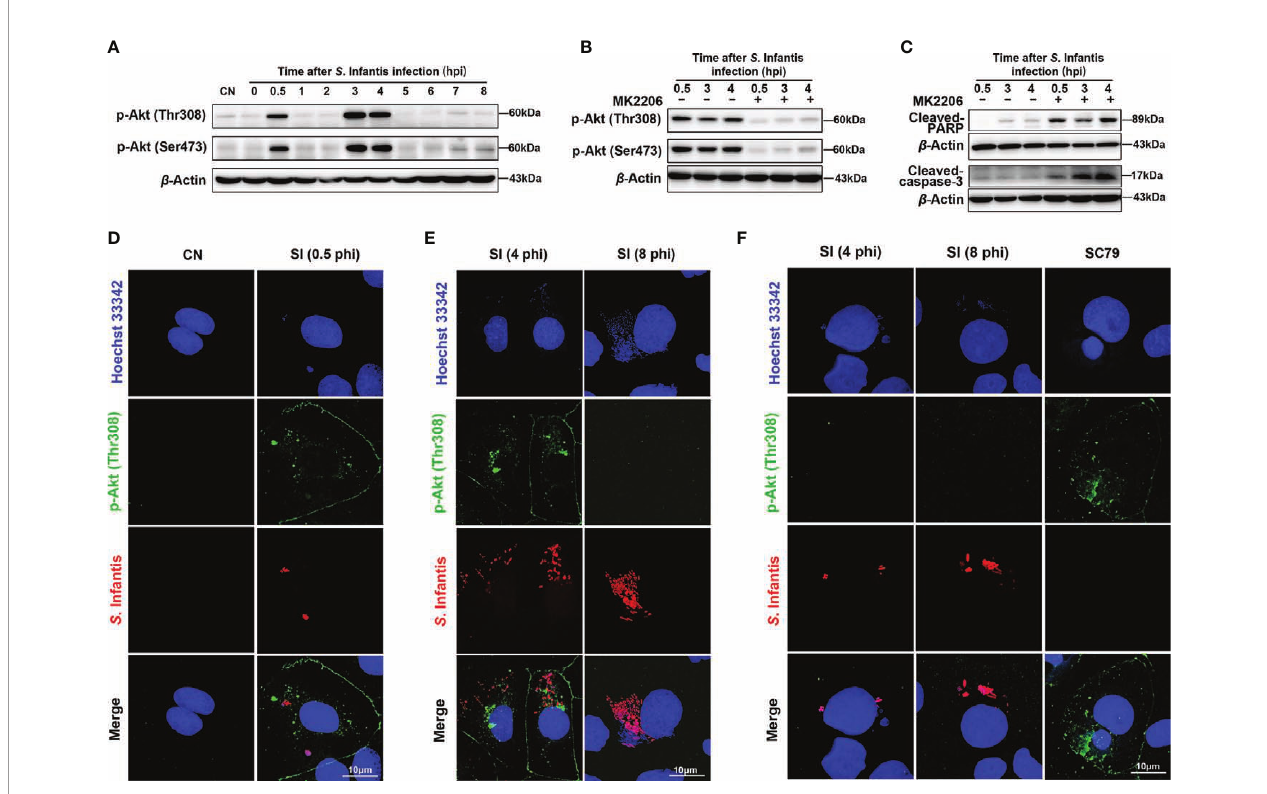
FIGURE 2 | Cytosolic hyper-replicating S . Infantis inhibited apoptosis by intermittently phosphorylating Akt. (A) Western blot analysis of p-Akt (Ser473) and p-Akt (Thr308) protein expression levels at 0, 0.5, 1, 2, 3, 4, 5, 6, 7, 8 hpi, respectively. CN, control. (B) Immunoblotting veri fi ed the inhibitory effect of MK2206 on p-Akt (Ser473) and p- Akt (Thr308) protein expression levels at 0.5, 3, and 4 hpi. (C) Western blot analysis of Cleaved-caspase-3 and Cleaved-PARP protein expression levels at 0.5, 3, and 4 hpi after after p-Akt was suppressed by MK2206. (D – F) Immuno fl uorescence staining analysis p-Akt (Thr308) distribution. CN, control; SI, S . Infantis. (D) Distribution of p-Akt (Thr308) in all infected cells at 0.5 hpi. (E) Expression of p-Akt (Thr308) in infected cells containing cytosolic hyper-replicating S . Infantis at 4 and 8 hpi. (F) Expression of p- Akt (Thr308) in infected cells without cytosolic hyper-replicating S . Infantis at 4 and 8 hpi. At least 100 cells were counted for each group. Red: S . Infantis. Green: p-Akt (Thr308). Blue: Hoechst 333342. Data were presented as the mean ± SEM from three independent experiments (n =